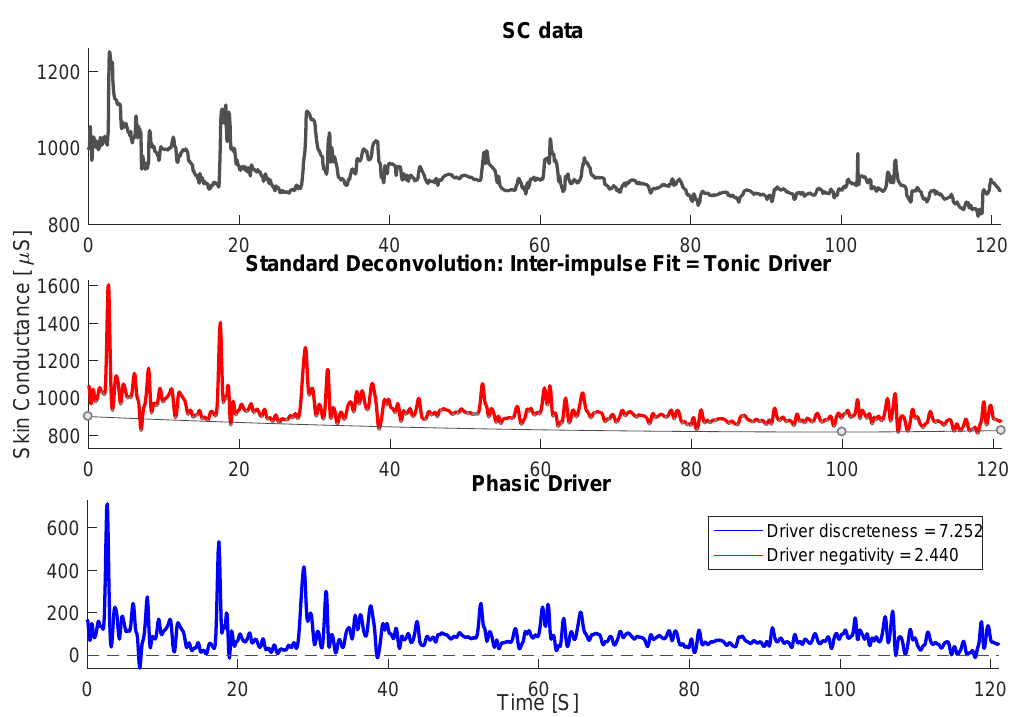
Figure 5. Continuous decomposition analysis (CDA) for distracted scenario, ( top ): original skin conductance (SC) signal; ( middle ): decomposed Tonic and Phasic driver and ( bottom ): Phasic